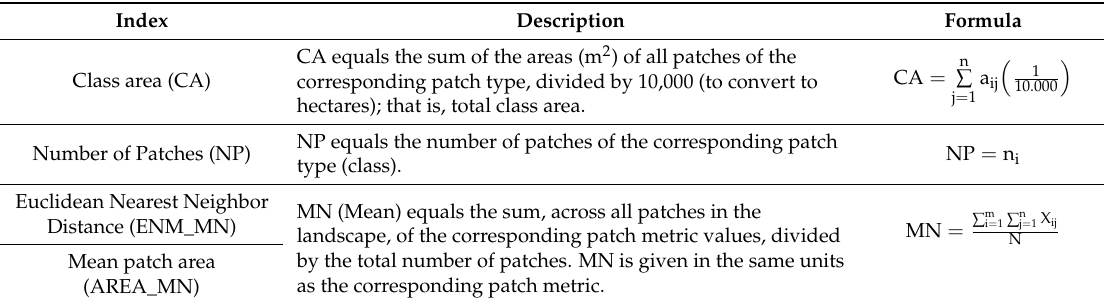
Table 6. Indices used of FRAGSTATS.